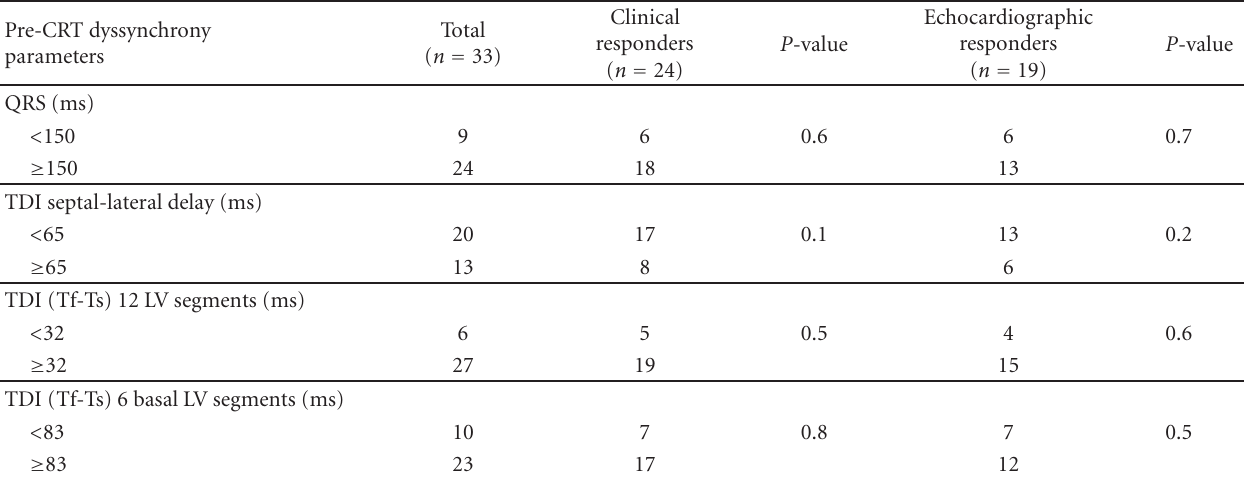
Table 4: Assessment of QRS duration and echocardiographic dyssynchrony parameters validated in other trials to predict long-term clinical and echocardiographic